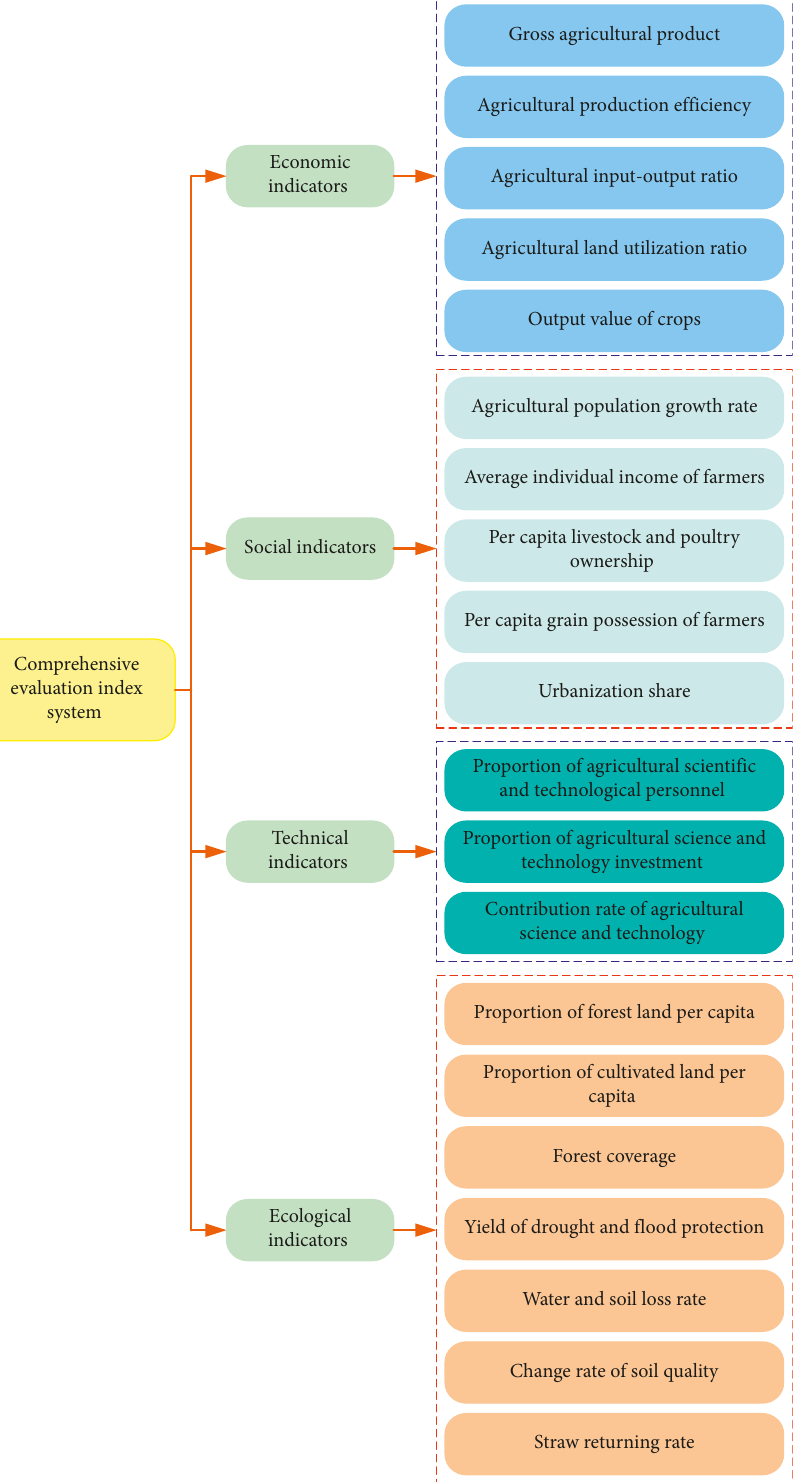
Figure 6: Schematic diagram of construction of comprehensive evaluation index system for the development of ecological agriculture industry chain